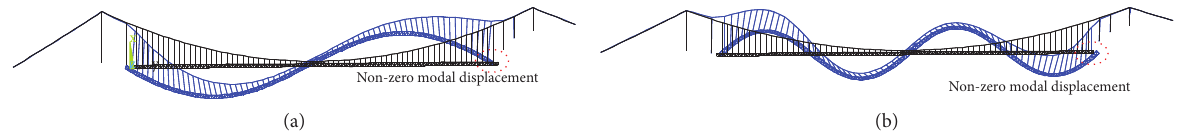
Figure 4: First two-order asymmetric vertical bending with longitudinal mode: (a) first order; (b) second order.